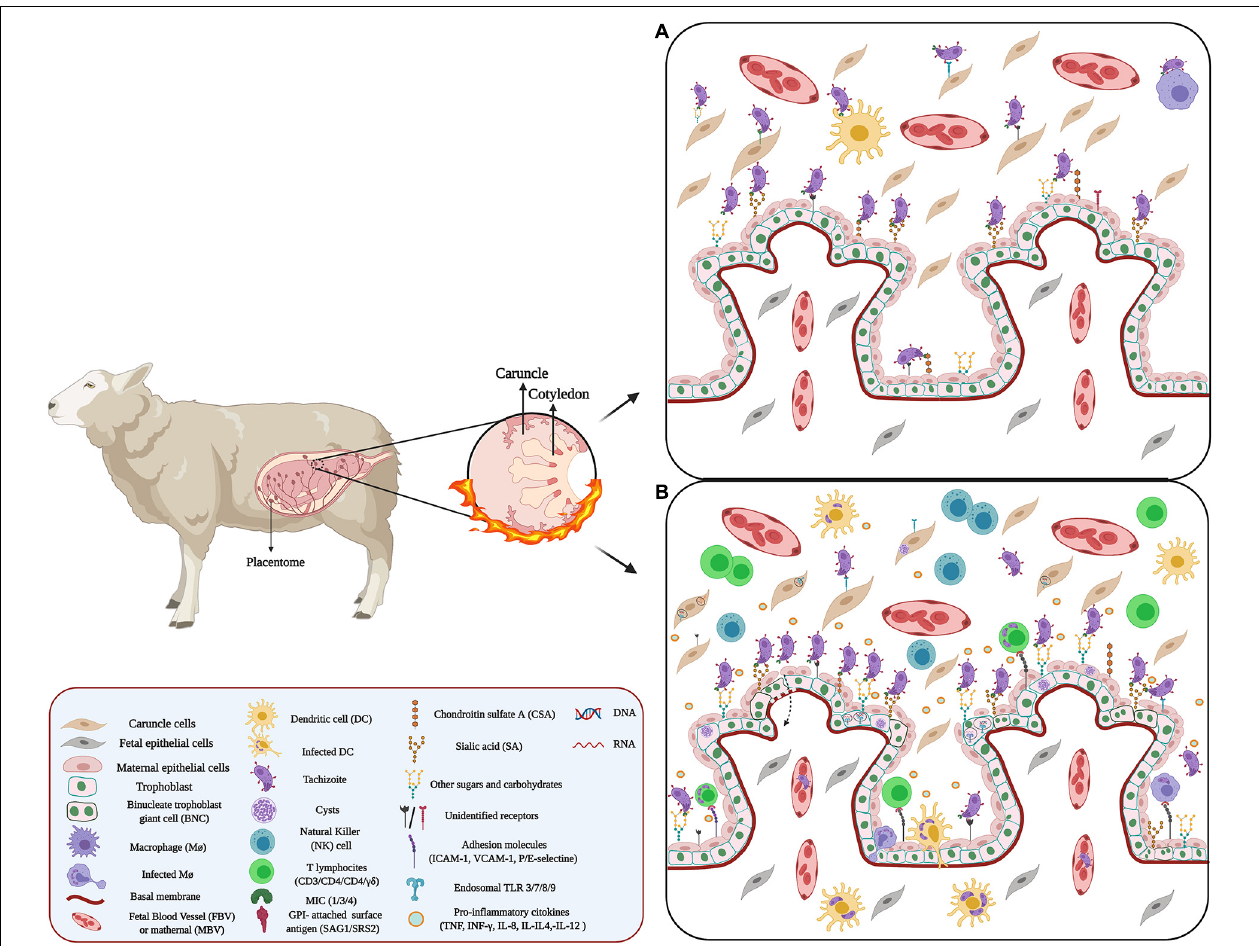
FIGURE 4 | Host–pathogen interaction between Neospora and placenta: (A) Adhesion of Neospora. Neospora adhesion to the placenta can occur through proteins belonging to the SAG, SRS, and MIC families. These proteins expressed on the surface of the parasite act as surface antigens and ligands for molecules present on the surface of placental cells. Possibly, these protein proteins could bind to proteoglycans and placental adhesion molecules. (B) Microenvironment and inflammatory response against Neospora . Inflammation in the IVS and caruncle could be attributed to chemokines and cytokines secreted by maternal Mo, T cell, as well as ST and caruncle cells. Many of these cytokines and chemokines promote cell recruitment. Additionally, infection of some cells of the maternal immune system, such DCs, and M (cid:56) , by Neospora alters the migration of these cells, using them as Trojan